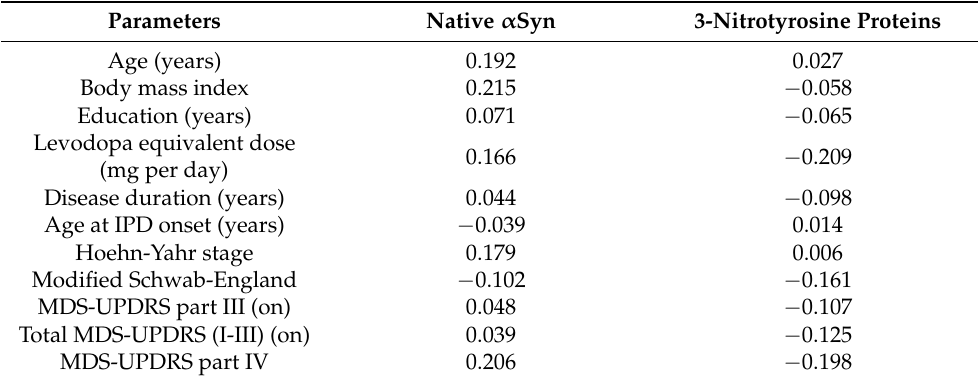
Figure 1. Individual total α Syn concentration (pg/mL) in ( A ) saliva and ( B ) serum in patients with IPD and control participants, as measured with ELISA. Mean and standard deviation are represented with solid lines. Abbrev.: α Syn, α -synuclein; IPD, idiopathic Parkinson’s disease; ELISA, enzyme-linked immunosorbent assay. Table 2. Correlation of native α Syn and 3-nitrotyrosine proteins concentration in the saliva with demographic and clinical parameters in patients with idiopathic Parkinson’s